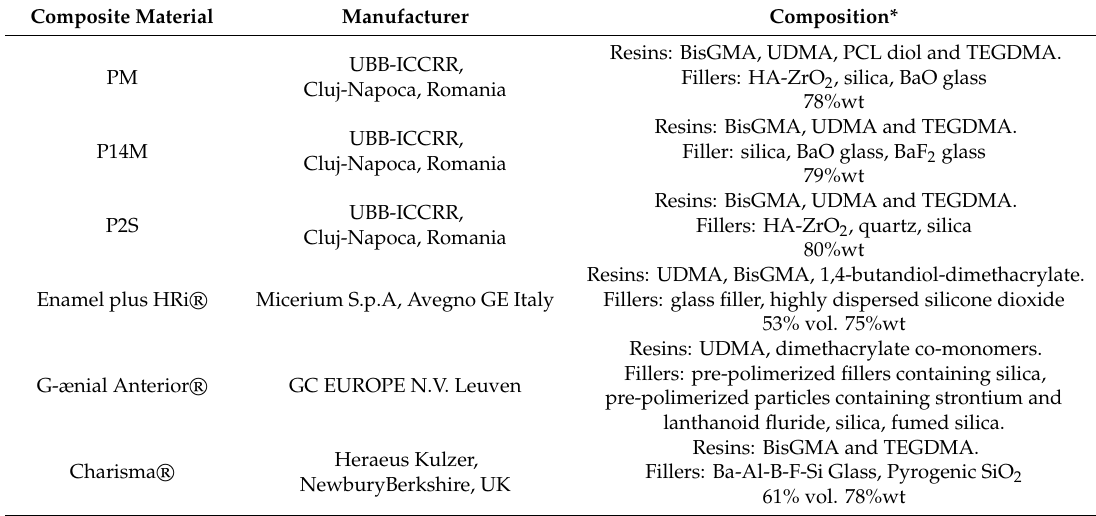
Table 1. Composition of experimental and commercial dental restorative